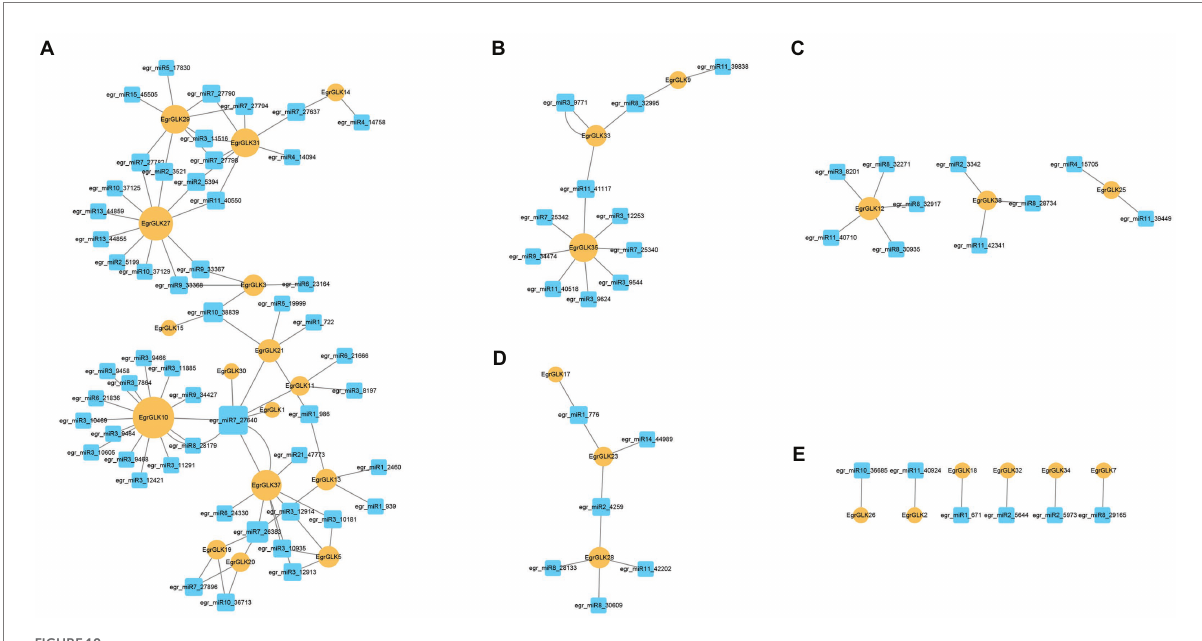
FIGURE 10 Regulatory networks were divided into (A-E) according to the number of targeting relationship between miRNAs and EgrGLK